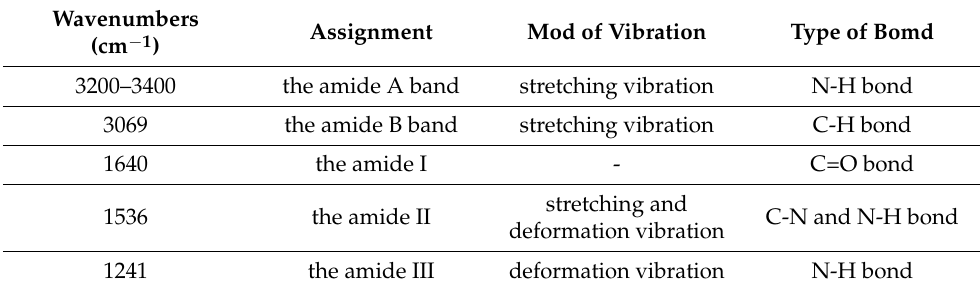
Table 2. The main absorption bands of GelMA and their assignments.